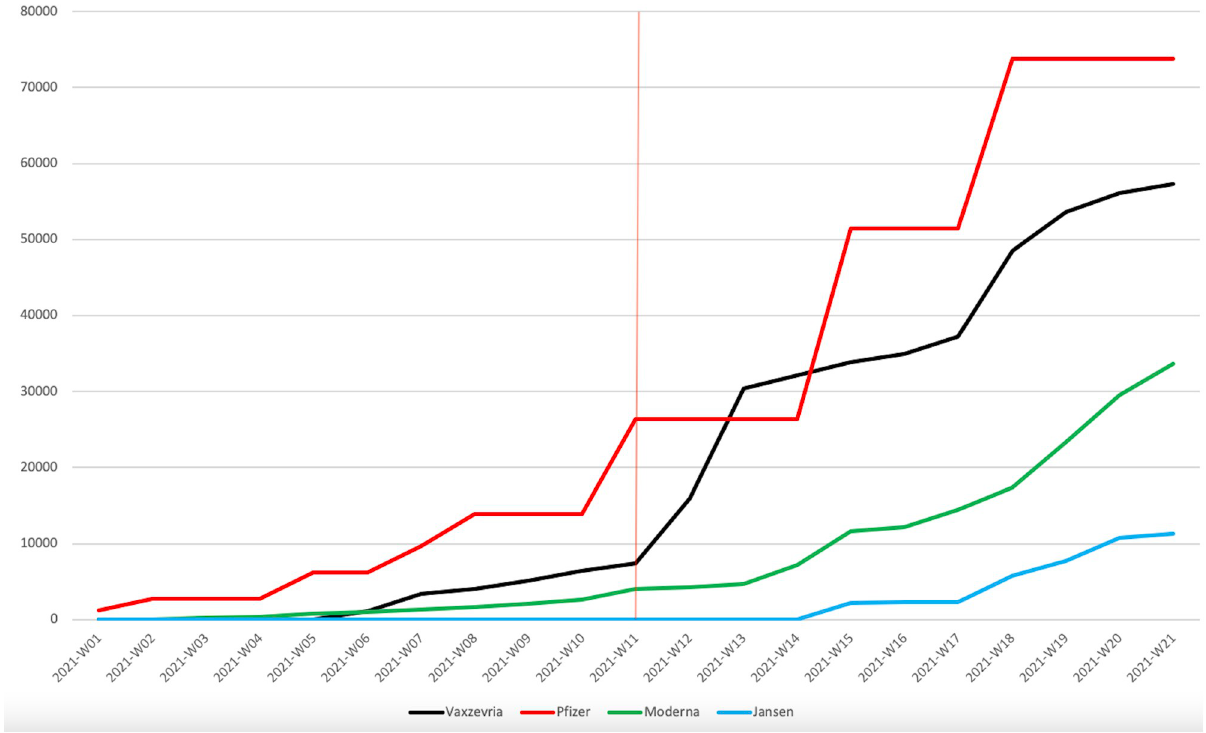
Fig 6. Cumulative number of doses administered in Luxembourg, by manufacturer. Notes : Source: https://vaccinetracker.ecdc.europa.eu.